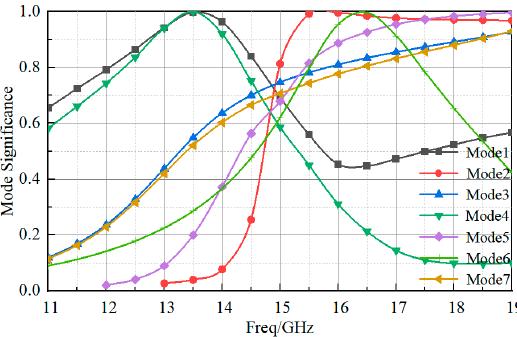
Figure 5. The mode significance of the coplanar radiator.